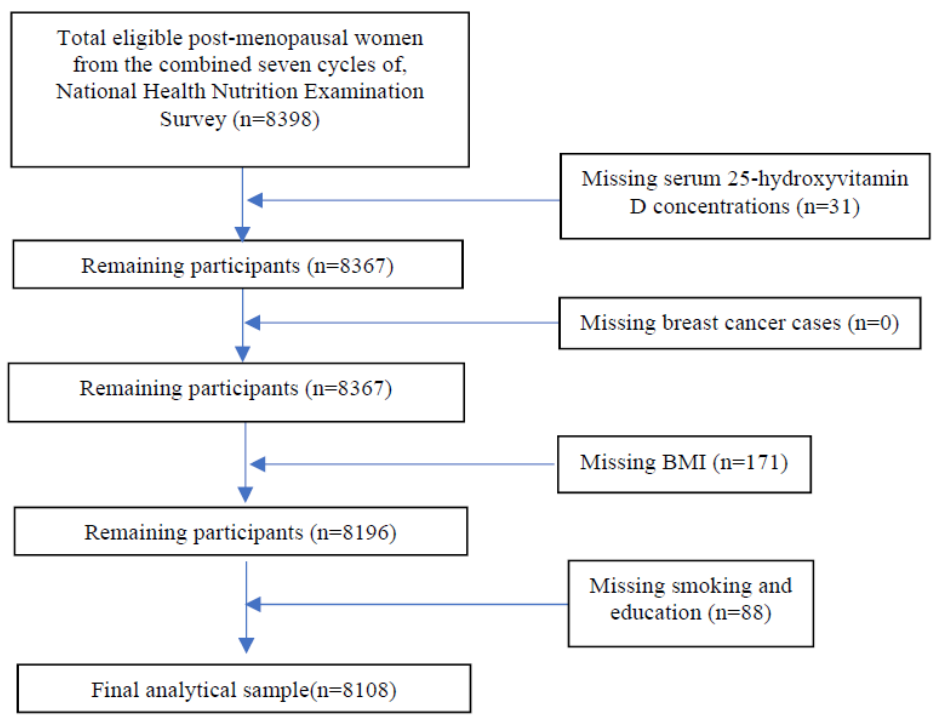
Figure 1. STROBE flow chart: Study sample derivation for the association between serum 25-hydroxyvitamin D concentrations and breast cancer prevalence in postmenopausal women in the USA using the combined data from seven cycles of National Health and Nutrition Examination Surveys, 2001–2014.